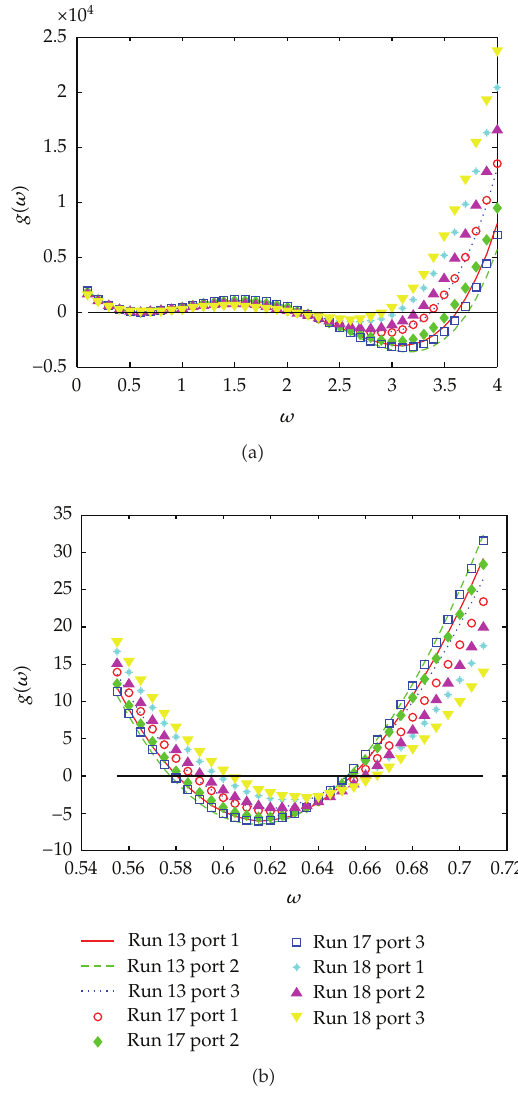
Figure 2: g (cid:2) w (cid:3) for Runs 13, 17, and 18 over (cid:2) a (cid:3) a wide range of ω from 0 to 4 and (cid:2) b (cid:3) a narrow range of ω .